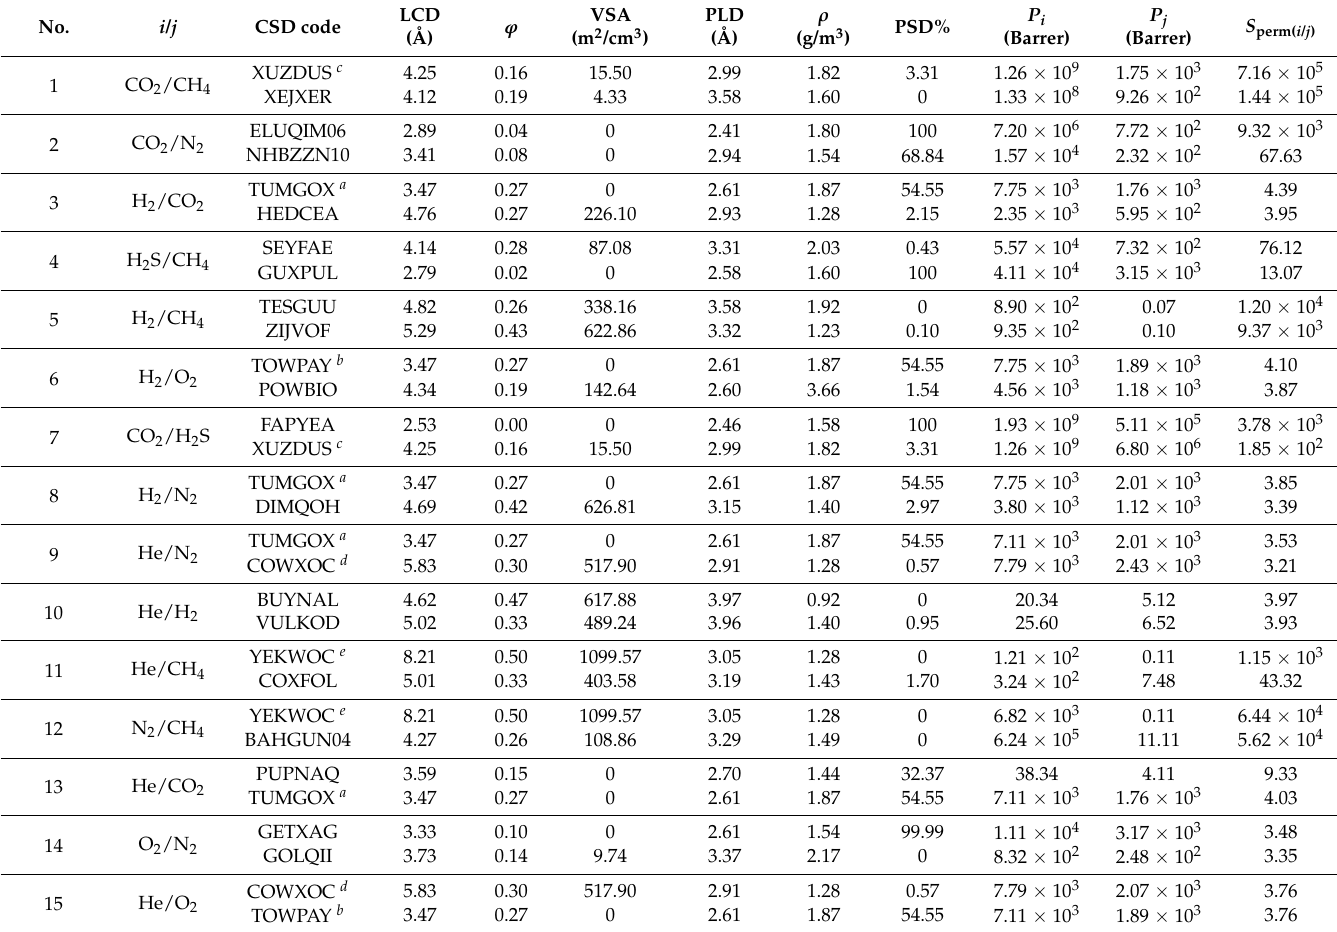
Table 2. Best CoRE-MOFMs. LCD: large cavity diameter, PLD: pore limiting diameter, PSD: pore size distribution, VSA: volumetric surface area, CSD: Cambridge structural